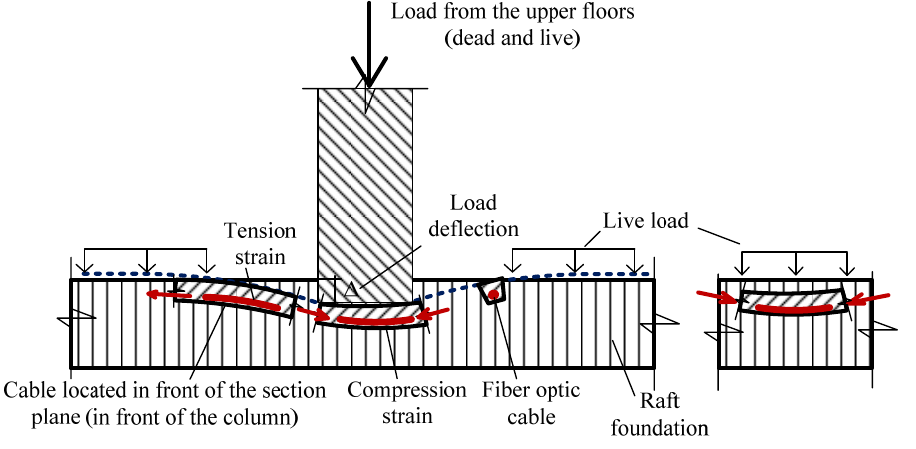
Figure 17. Strains near point loads (columns).